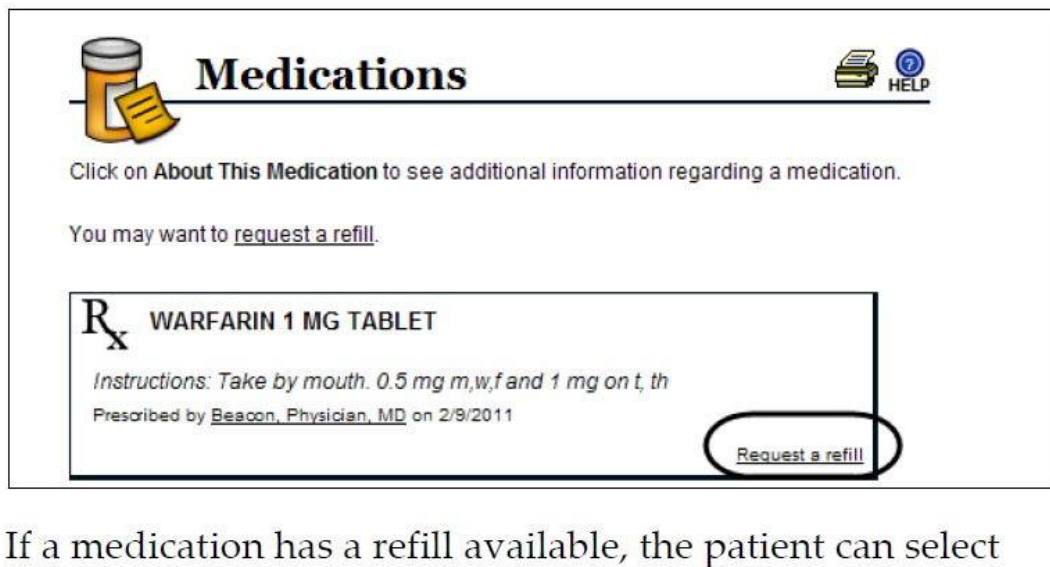
Figure 2. Prescription refill requests in personal health